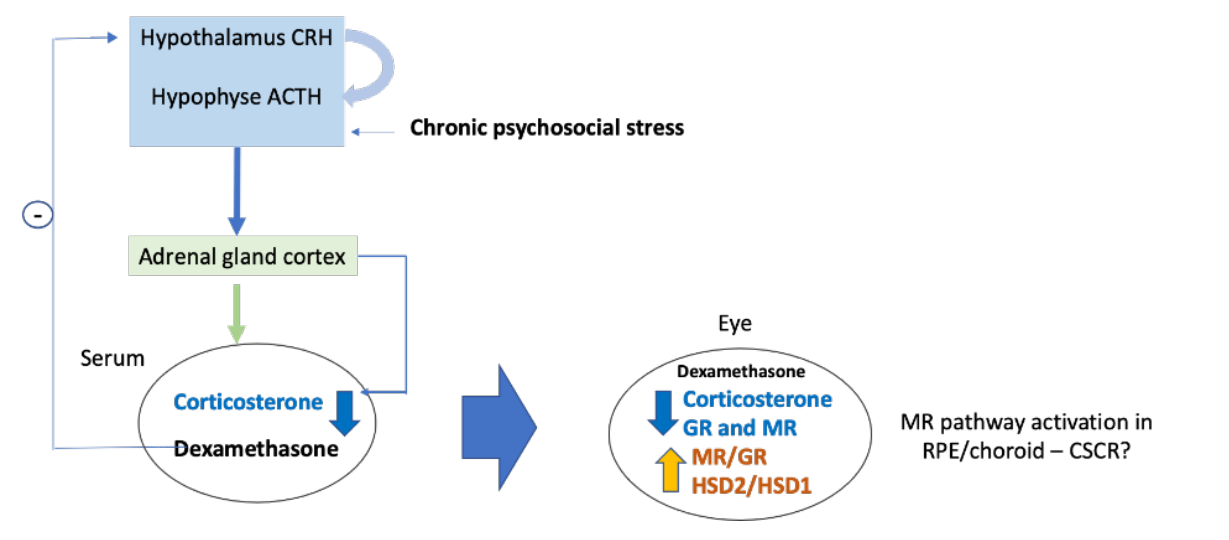
Figure 6. Schematic representation of the ocular consequences of HPA axis brake on ocular GR/MR pathways [34,49,61].